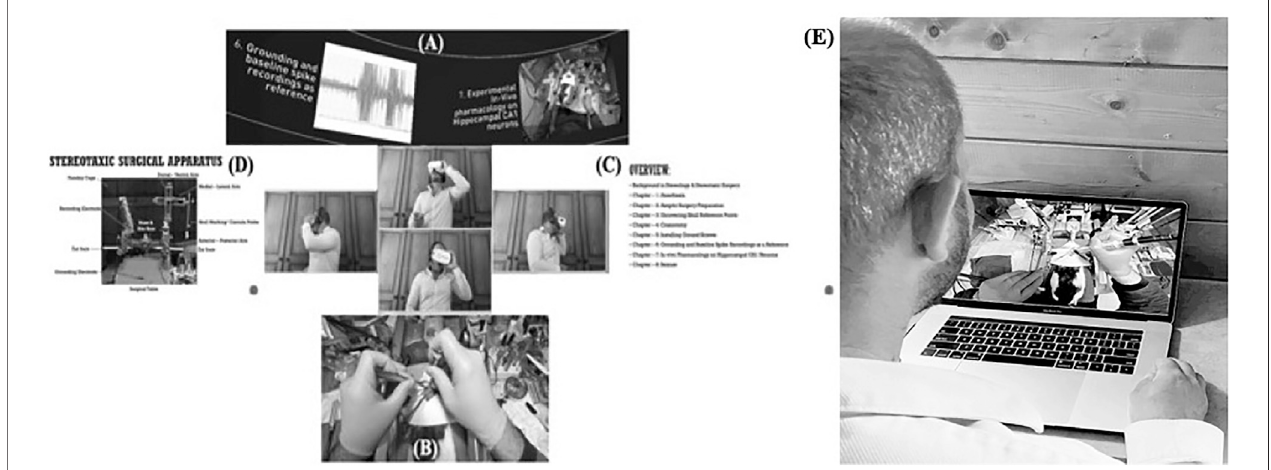
FIGURE 2 | 180 ° video VR HMD perspective of the POV of the student/learner. (A) Learning modules displayed when looking up. (B) 180 ° video VR HMD audio/ video experience whenlookingdown. (C) Microsoft PowerPoint slidesdisplayingthelecture totheleft. (D) Additionalspeci fi cimages withthere fi ned detailsforteaching emphasis. (E) FPV of the student/learner for the comparison 3D video computer display